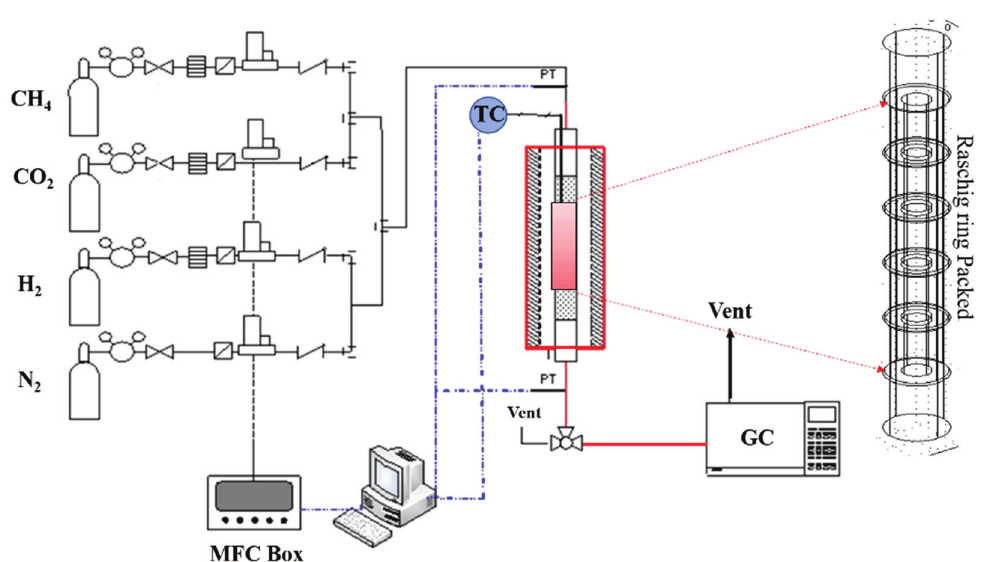
Fig. S3 – Schematic diagram of the DMR system